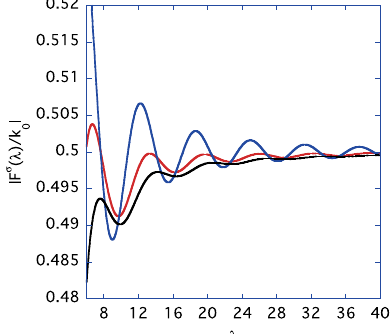
FIG. 5. The σ dependence of j F σ ð λ Þ =k 0 j is shown. The results for the values of σ are 2 (blue), 2.63 (red) and 3 (black) are shown.